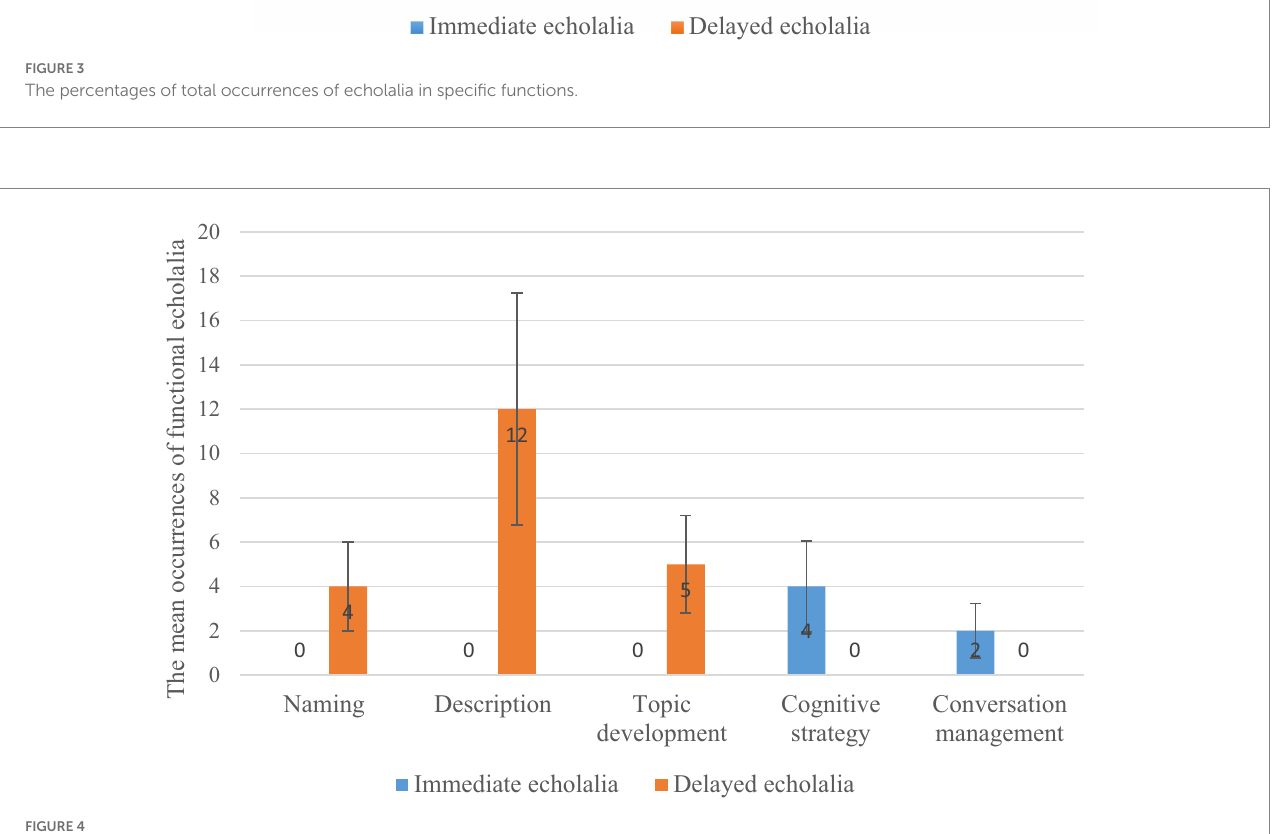
FIGURE 4 The mean occurrences of echolalia in specific